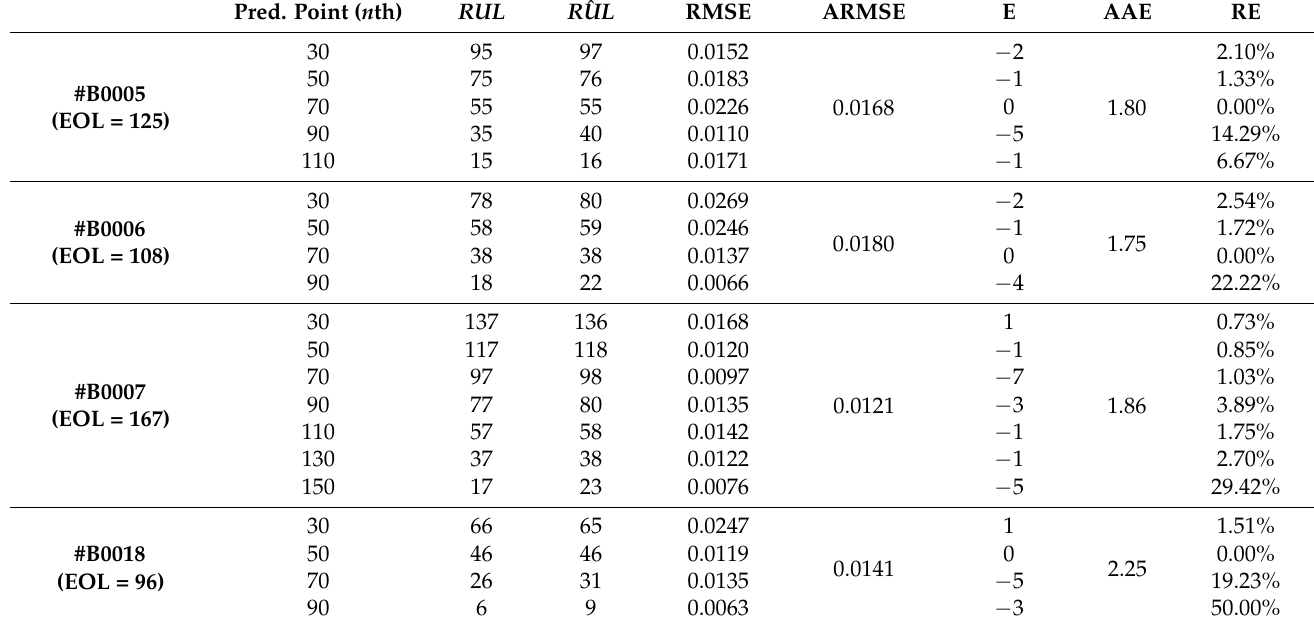
Table 7. The errors of the RUL prediction of batteries #5, #6, #7, and #18 at different predicting (Pred.) points with the SR